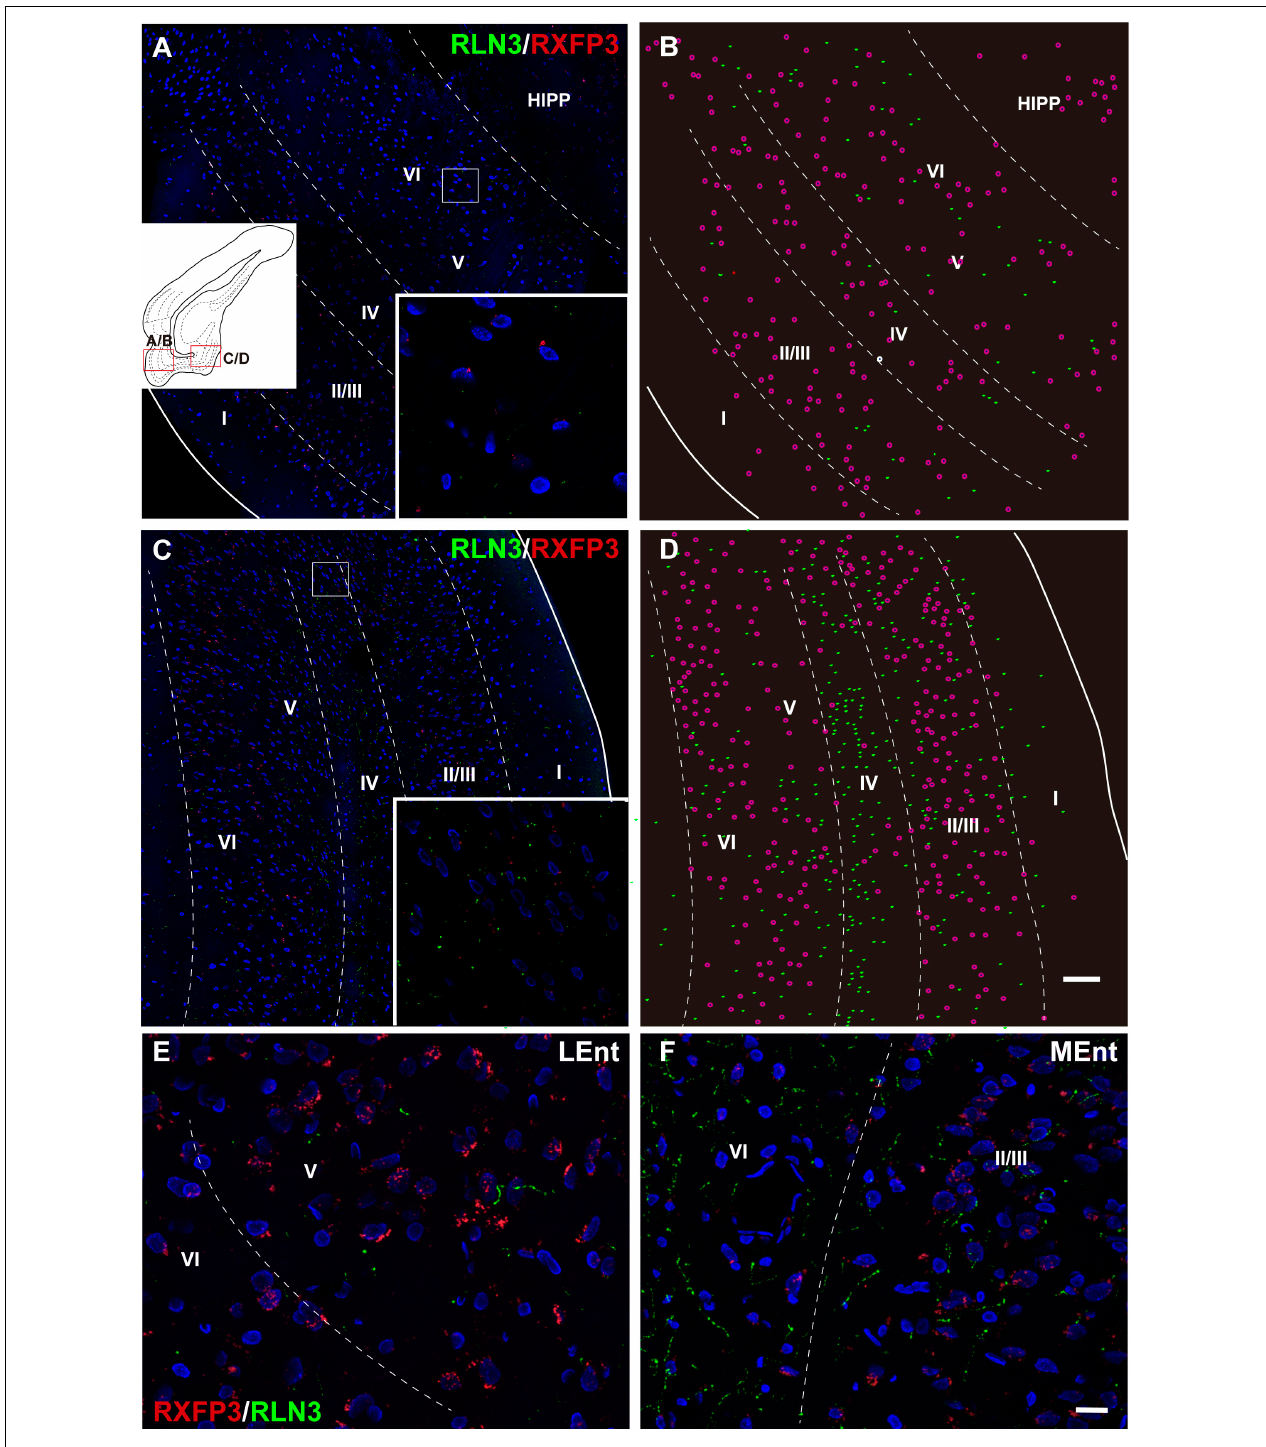
FIGURE 12 | Distribution of RXFP3 mRNA in neurons of the LEnt and MEnt and their juxtaposition to RLN3 fibers. (A) A direct 1 µ m single optical section of the LEnt captured with a 20 × objective labeled for RXFP3 mRNA using RNAscope ISH and for RLN3 IF. Inset illustrates the presence of RXFP3 mRNA (small red dots) surrounding a DAPI-labeled nucleus and several RLN3 fibers (green). (B) A plot of the distribution of RXFP3 mRNA-positive somata, and RLN3 fibers from the section in (A) . (C) A direct 1 µ m single section of the MEnt captured with a 20 × objective labeled for RXFP3 mRNA and for RLN3. Inset illustrates the presence of RXFP3 mRNA (small red dots) surrounding a DAPI-labeled nucleus and several RLN3 fibers (green). (D) A plot of the distribution of labeled RXFP3 mRNA-positive somata, and RLN3 fibers from the section in (C) . Calibration bar (A–D) , 100 µ m. (E) Detail of double-labeling in the inner layers of the LEnt. (F) Detail of double-labeling in the inner layers of the MEnt. Calibration bar (E,F) 20 µ m.